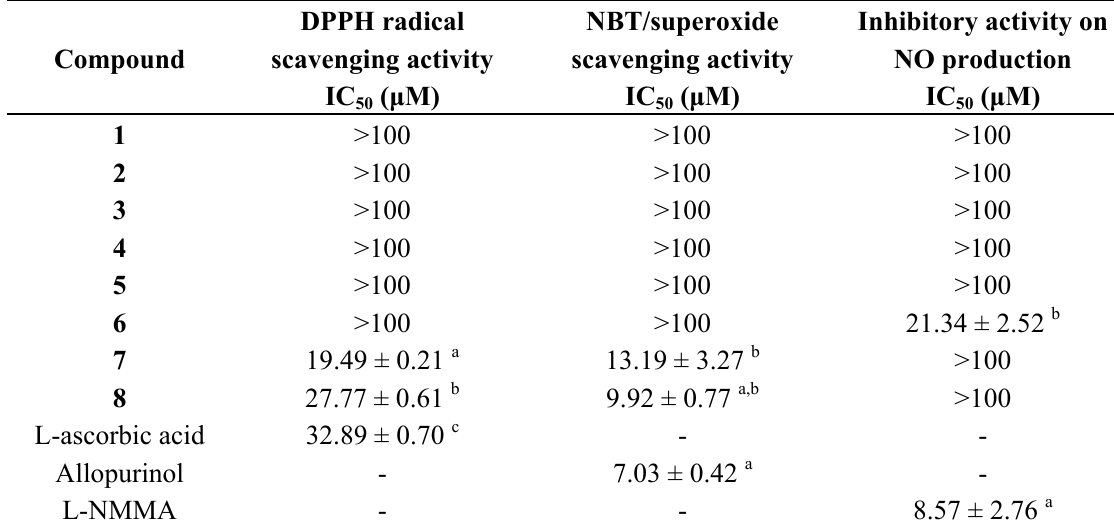
Values represent means ± S.D. of three determinations. Values bearing different superscripts in the same column are significantly different ( p < 0.05). -, Not